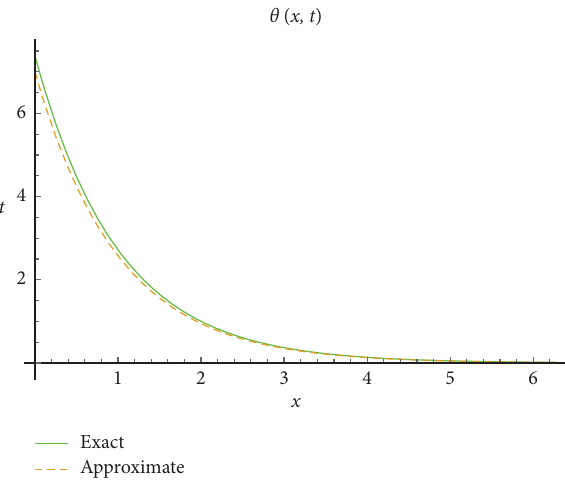
Figure 2: 2D plot for ϑ ( x, t ) with various parameter of t